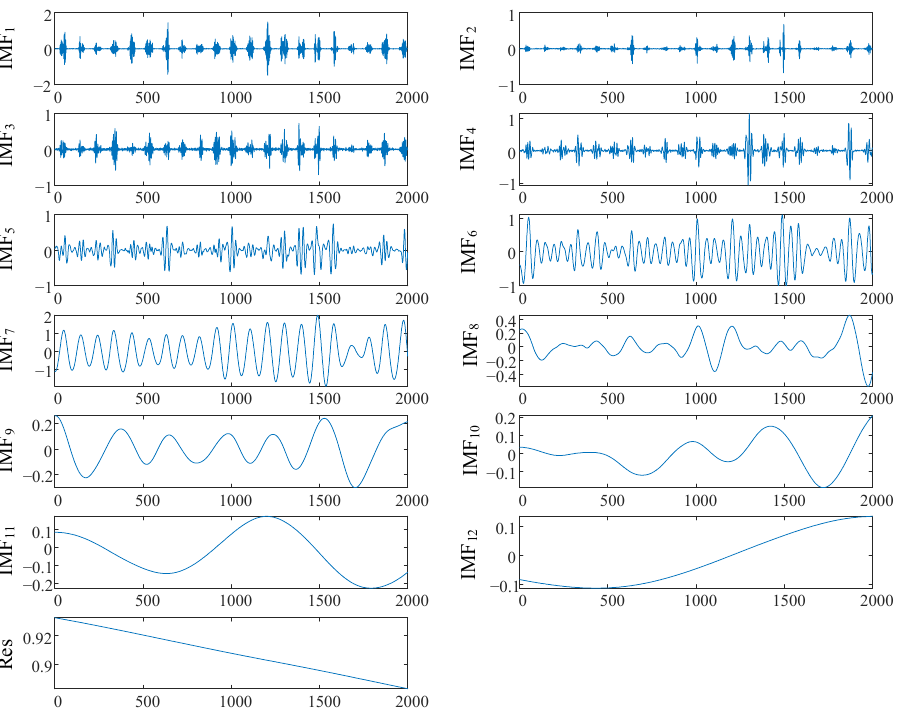
Figure 7. The CEEMDAN results for changeable weather CSPC.